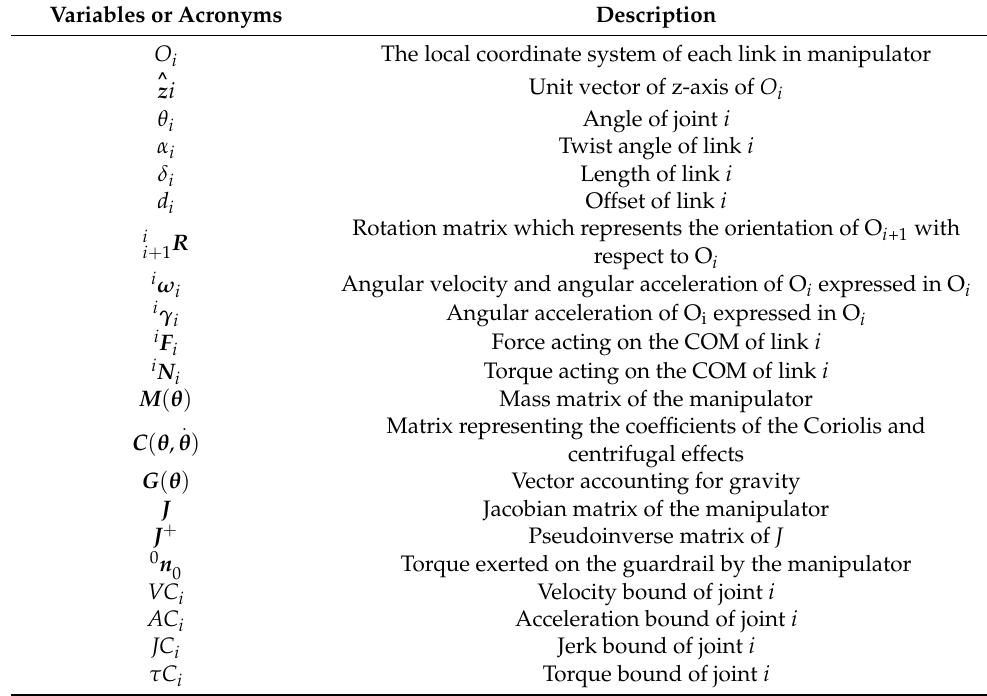
Table A1. The description of variables and